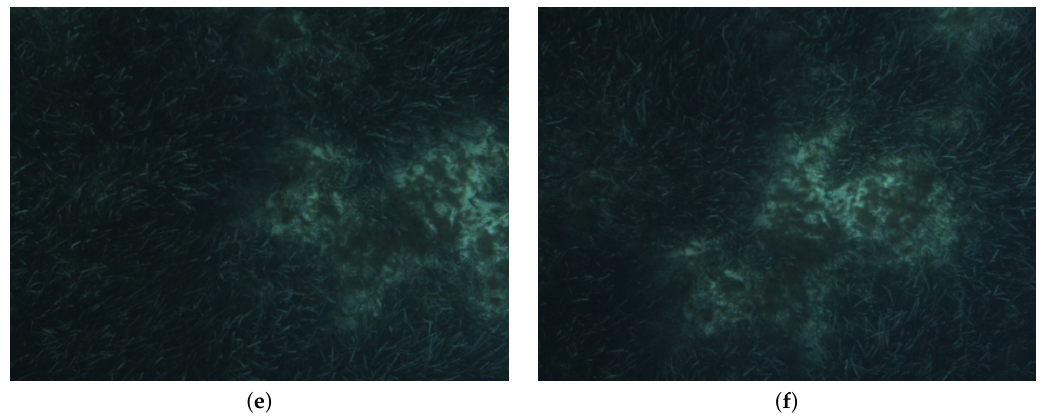
Figure 7. Examples of images in V 5 ( a , c , e ) and V 6 ( b , d , f ): Each row shows images with partial